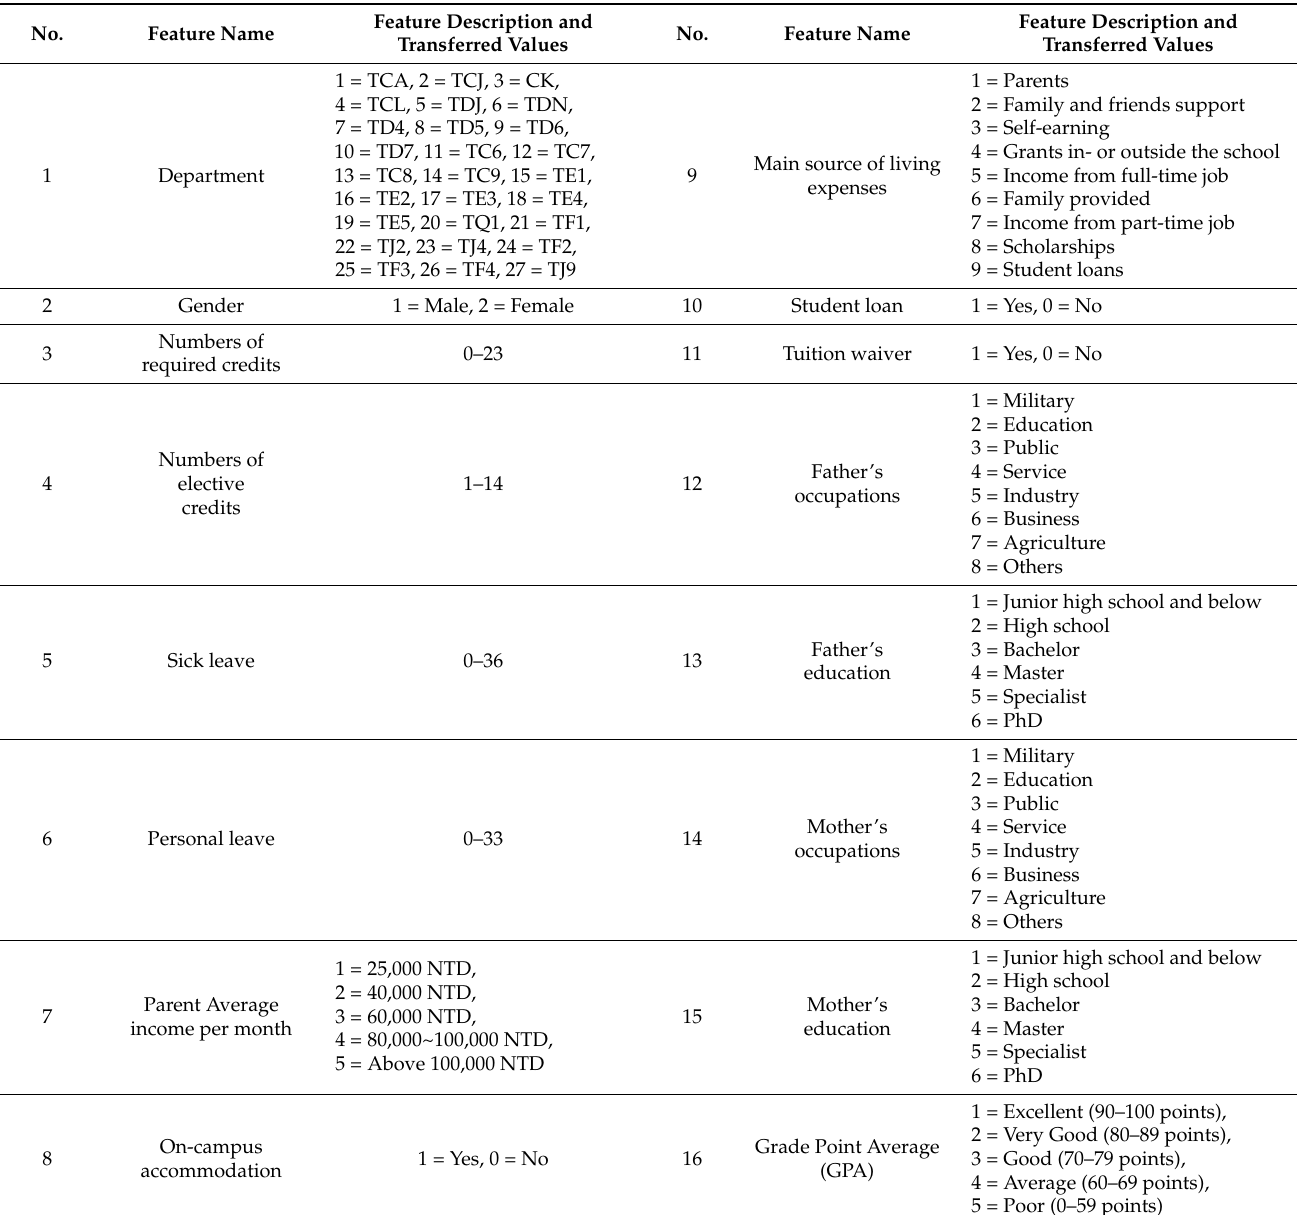
Table 1. The employed input and output data description and